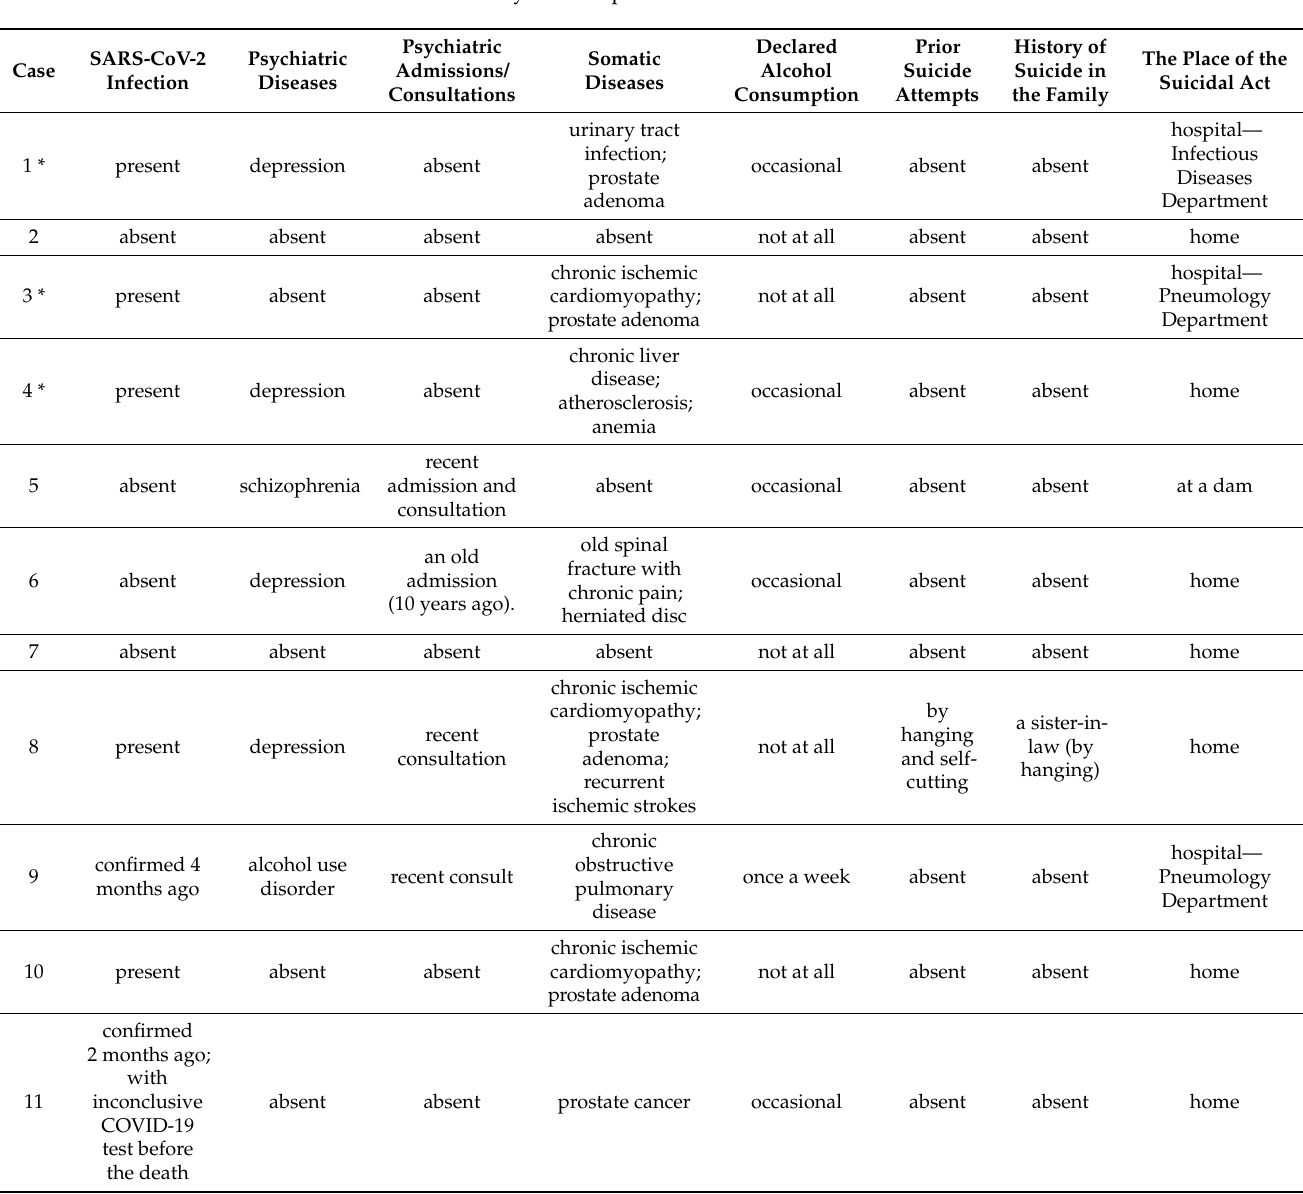
Table 2. Medical history data, declared alcohol consumption, prior suicide attempts, history of suicide in the family and the place where the suicidal act